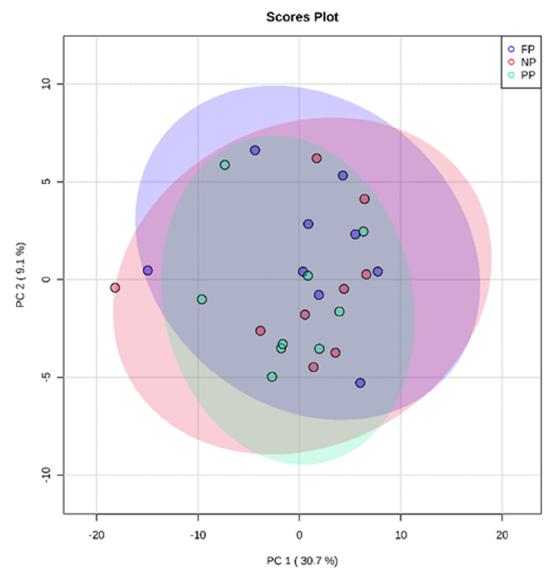
Figure 2. Principal component analysis (PCA) scores plot of metabolome distribution of plasma of offspring between the prenatal nutritional treatments at 30 days of age (NP, PP, and FP).